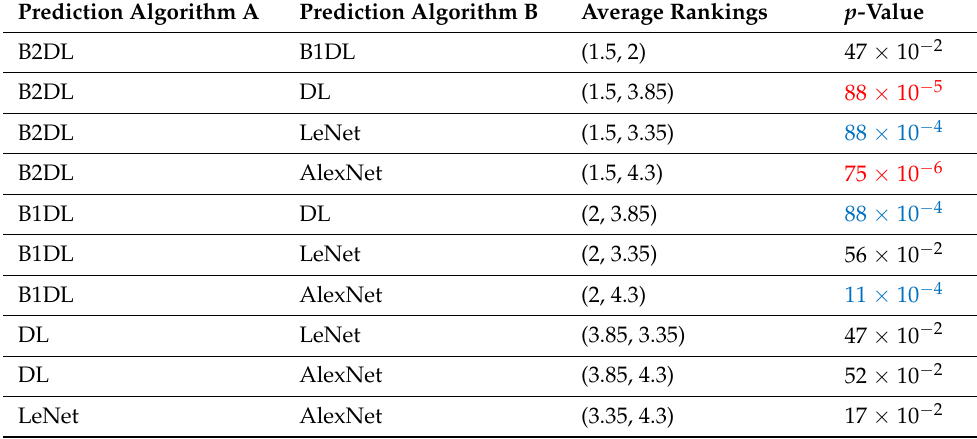
Table 5. p -values and average rankings of all pairs of the prediction algorithms in Figure 8a on the images pertaining to in vitro bovine embryos based on the Friedman test. The lower the rank of a prediction algorithm, the higher the performance. The difference between a pair of prediction algorithms with p < 0.001 (in red) is considered highly statistically significant. The difference between the two algorithms in a pair with p < 0.05 (in blue) is considered statistically significant. Prediction Algorithm A Prediction Algorithm